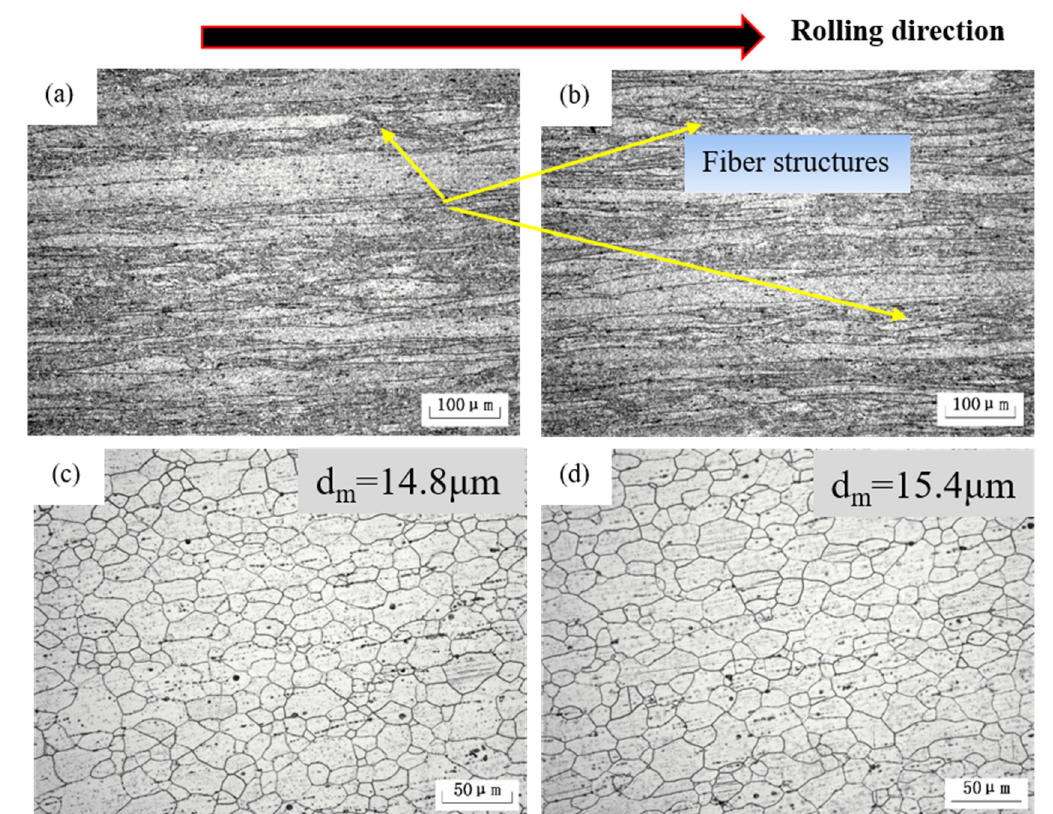
Figure 2. Microstructures of ( a ) as-rolled Al-4Mg alloy, ( b ) as-rolled Al-4Mg-0.6Ag alloy, ( c ) as- quenched Al-4Mg alloy and ( d ) as-quenched Al-4Mg-0.6Ag alloy.